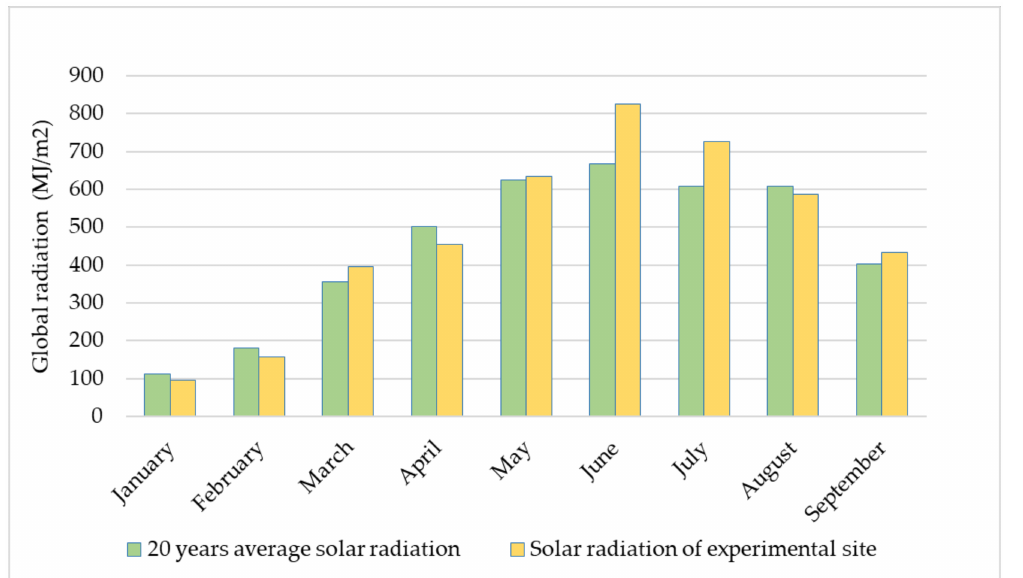
Figure 3. The 20-year average and 2021 monthly average of solar radiation at the experimental site (Debrecen-L á t ó k é p,